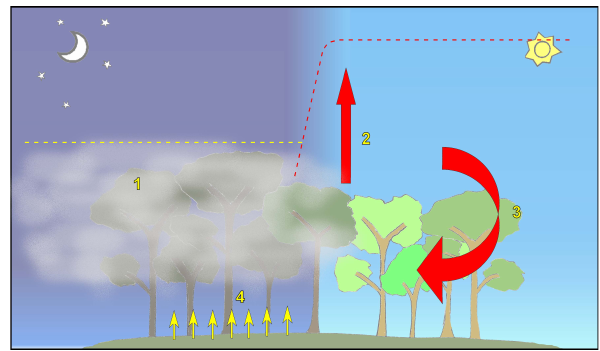
Fig. 14. A summary of the processes governing the particle number concentrations above and within the rainforest canopy. The yellow dashed line depicts the top of the stable nocturnal boundary layer, while the red dashed line marks the daytime mixed layer. The num- bers mark the important processes observed here, which are dis- cussed in the main text of Sect.